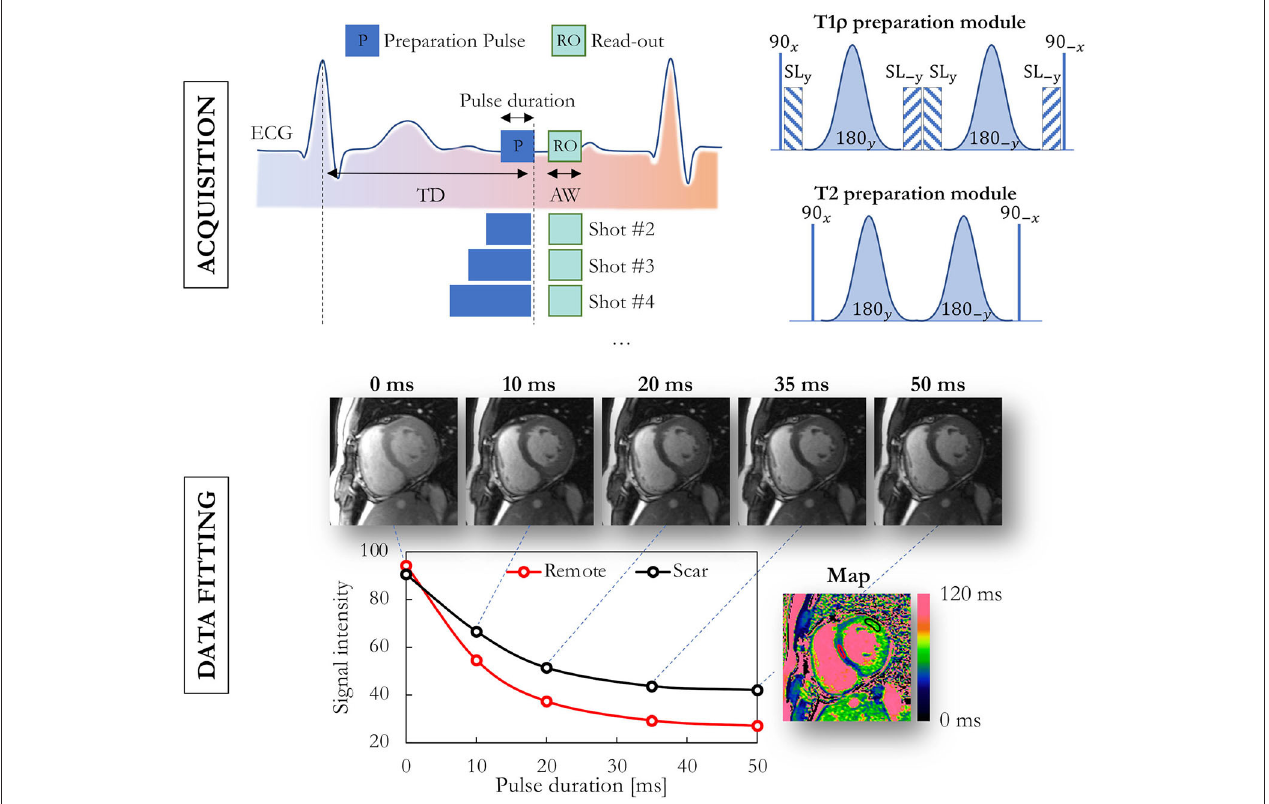
FIGURE 2 | Data acquisition and fitting process in routine myocardial parametric mapping. Multiple images at the same location are acquired with different preparation modules, illustrated here for T 1 ρ and T 2 mapping. Semi-adiabatic T 1 ρ and T 2 preparation modules are shown on the top-right. The obtained images with varying contrast are then fitted on a per-pixel basis, and a false-color map is used to display the obtained values. TD, trigger delay; ECG, electrocardiogram; AW, acquisition window; SL, spin